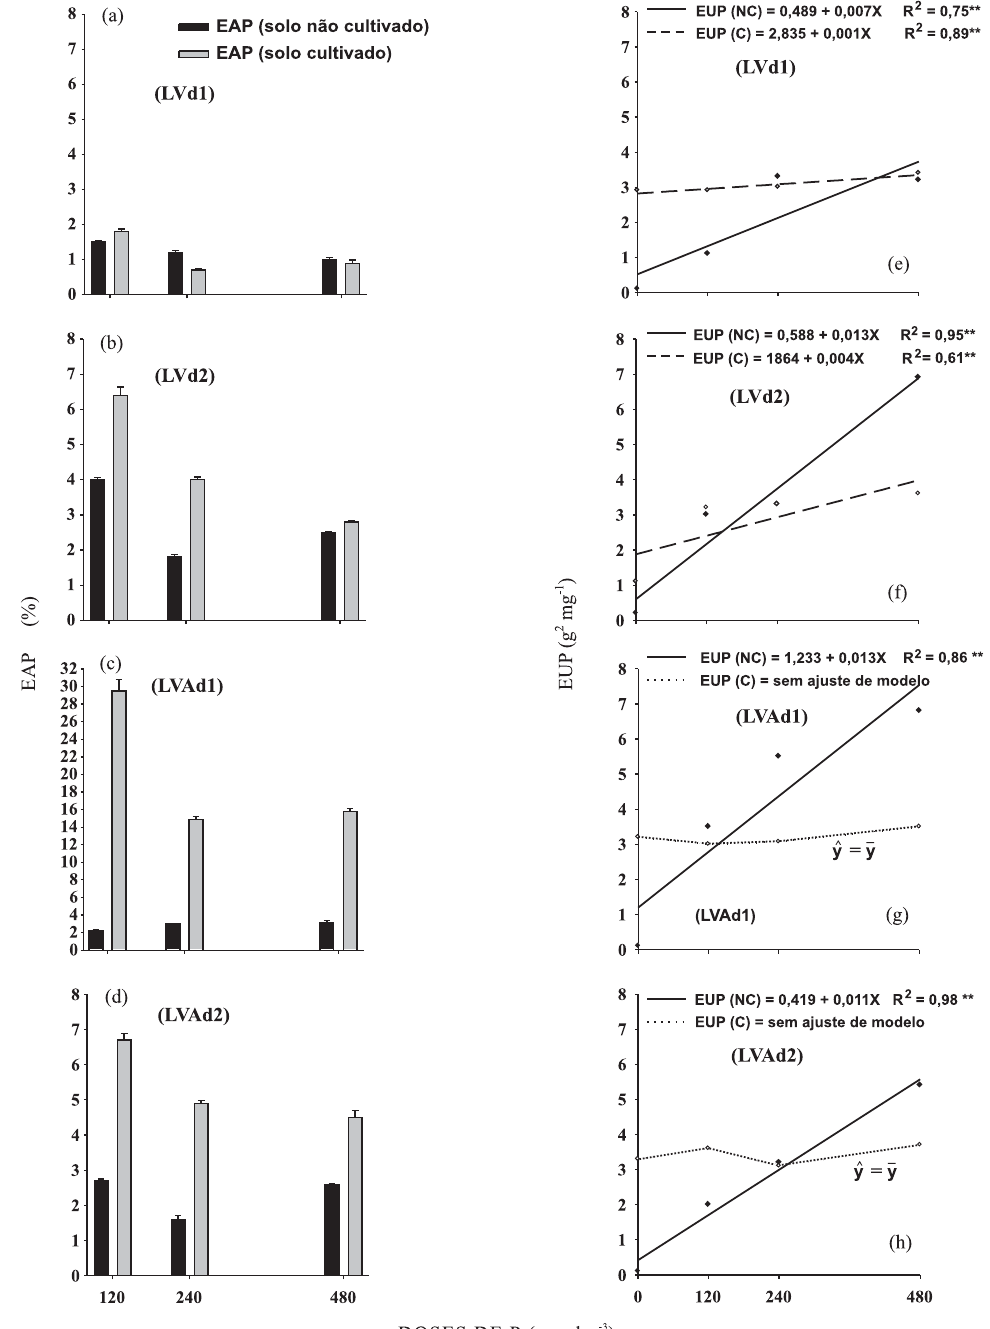
Figura 2. Eficiência de absorção de fósforo (EAP) (a, b, c e d) e eficiência de utilização de fósforo para grãos (EUP) (e, f, g e h) nos solos LVd1, LVd2, LVAd1 e LVAd2, em função das doses de P, na condição de solo não cultivado (NC) e cultivado